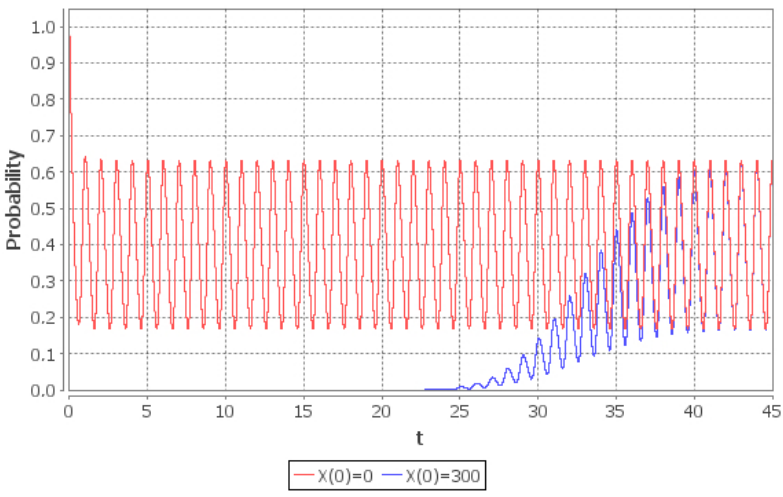
Figure 9. Rate of convergence of the empty system probability p 0 ( t ) in the interval [ 0,45 ] given two different initial conditions: p 0 ( 0 ) = 1 ( red line ), p 250 ( 0 ) = 1 ( blue line